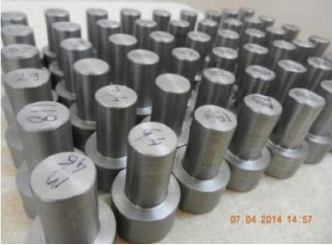
Fig.5. Handy surf E35 B